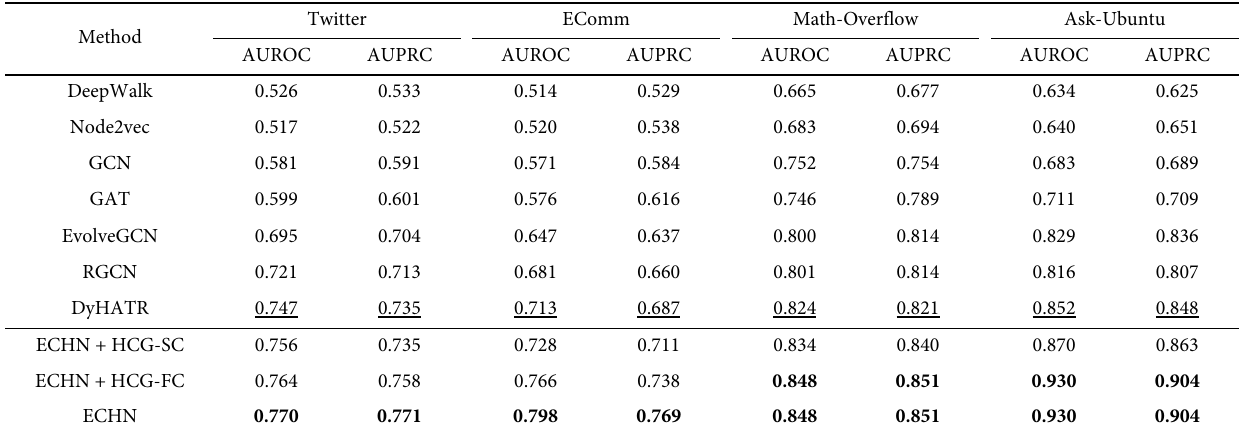
Table 2 Experimental results on the link prediction